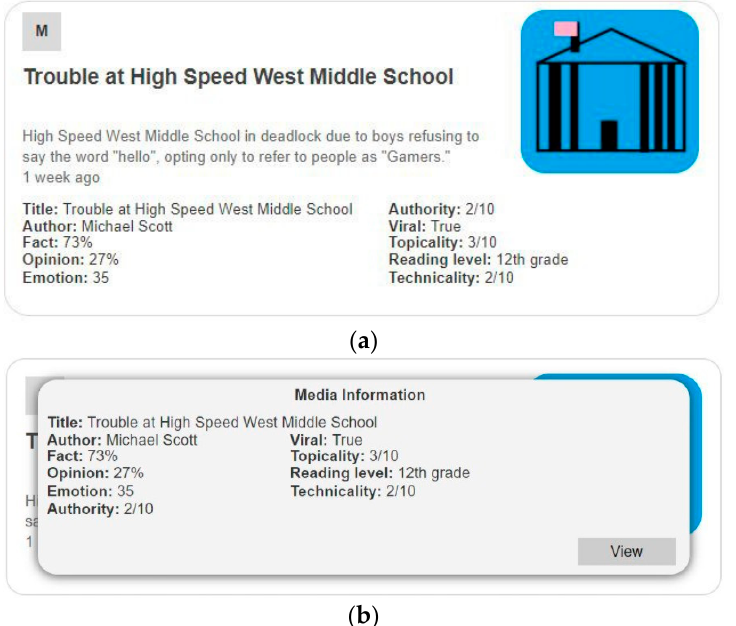
Figure 13. Examples of an informational labels (using categories proposed by Fuhr et al. [49]): ( a ) Label 1—supplemental with context; ( b ) Label 2—replacement without context.